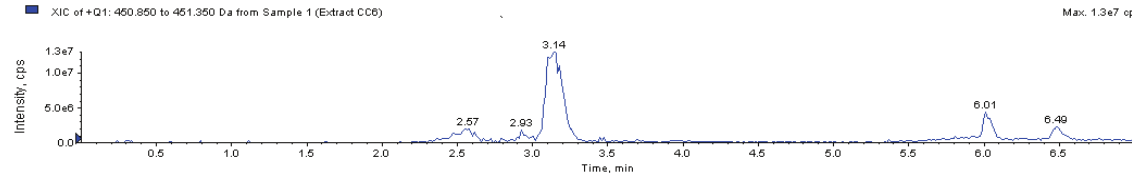
Figure 1. Extracted ion chromatogram for [M+H] + =451, corresponding to marein/flavanomarein (full scan acquisition, 80-700 Da, ESI, positive).